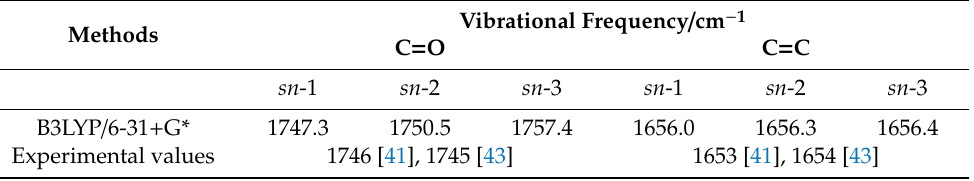
Table 3. Vibration frequencies of C = O and C = C in